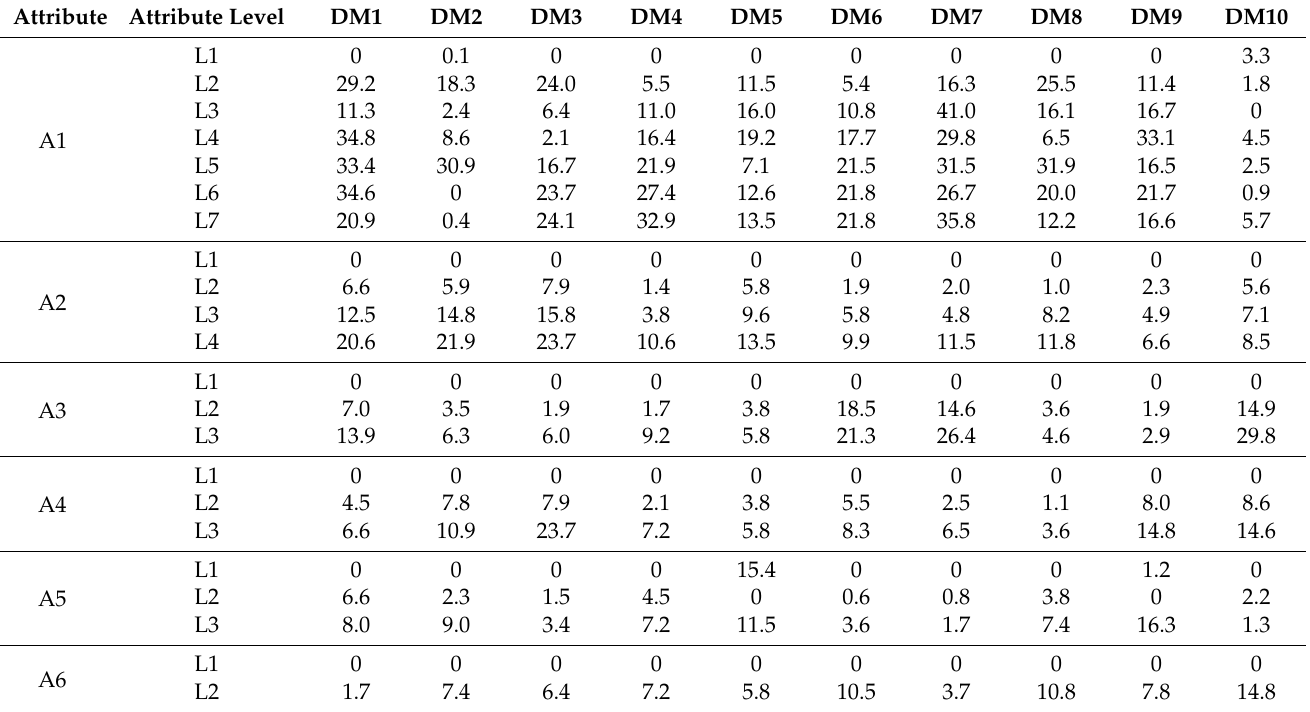
Table A4. Weighting of attribute level by respondent, presented as a %. DM1–10, respondent code. For definitions of attributes and levels, see Table